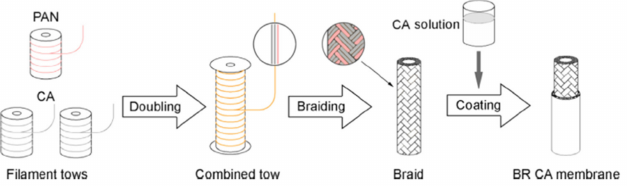
Figure 17. Schematic representation of BR CA membrane preparation process [230]. Reprinted/ adapted with permission from Ref. [230]. Copyright 2022, Elsevier.